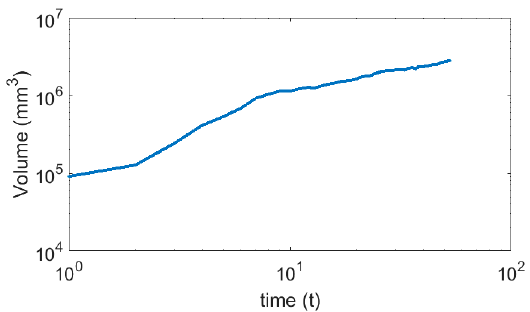
Figure 6. Temporal evolution of the eroded volume.